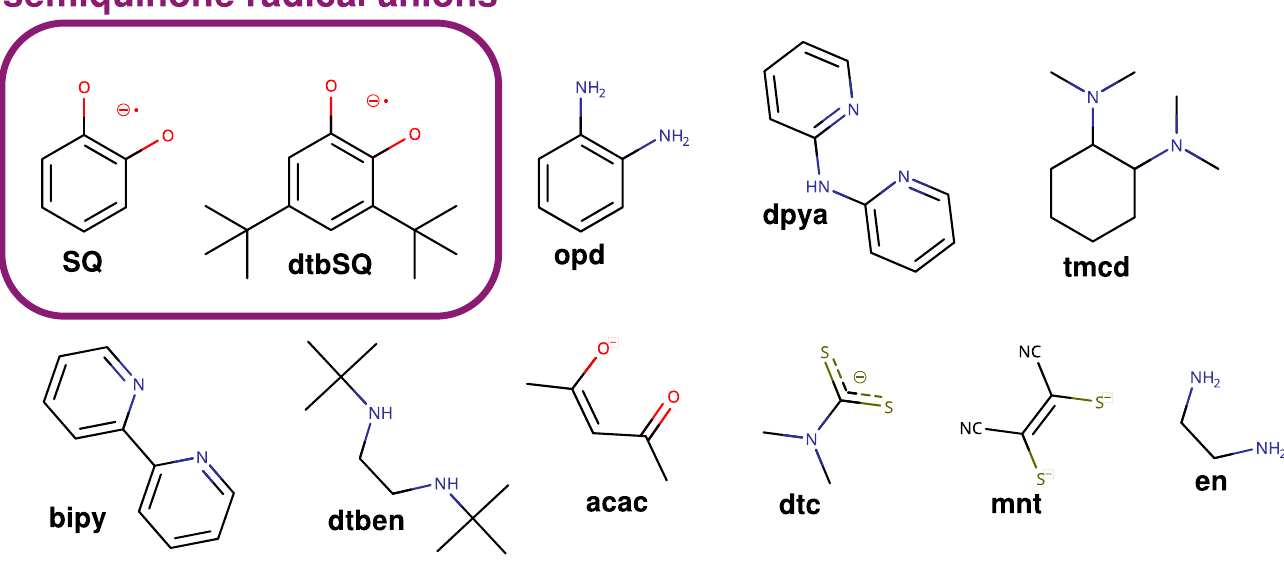
Figure 1. Ligands were used in this